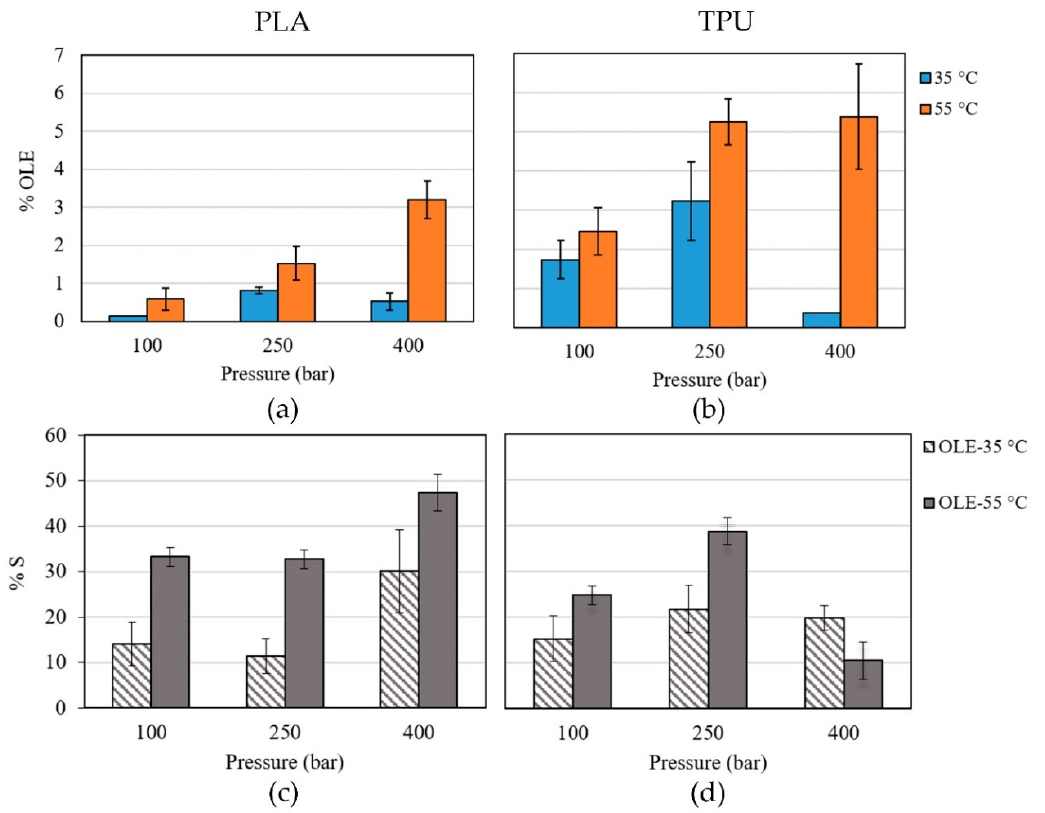
Figure 4. Ethanolic OLE loadings (%OLE) of ( a ) PLA and ( b ) TPU, and polymer swelling (%S) of ( c ) PLA and ( d ) TPU impregnated at 100, 250 and 400 bar, and 35–55 °C. All runs were performed in duplicate.